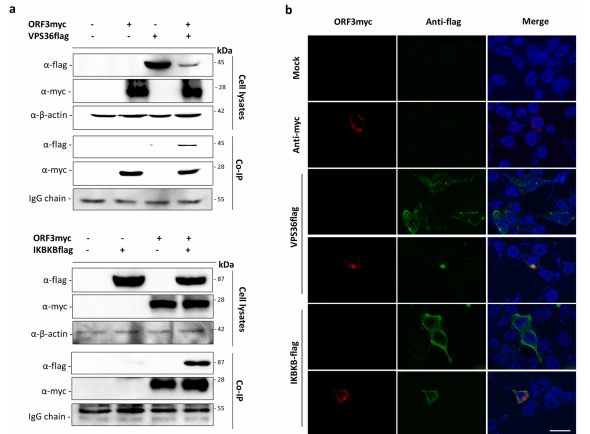
Figure 3. Validation of the interactions of ORF3 with VPS36 and IKBKB by co-immunoprecipitation and indirect immunofluorescence assay (IFA). ( a ) The plasmid expressing VPS36 or IKBKB with flag-tag at the C-terminus (pCAGGS_VPS36 or IKBKBflag) was co-transfected with pCAGGS_ORF3myc in HEK293T cells. At 24 hpt, cell lysates were subjected to immunoprecipitation using anti-myc bead. The immunoprecipitated proteins were probed with rabbit anti-flag and anti-myc antibodies. ( b ) The cells were incubated with mouse anti-myc and rabbit anti-flag as primary antibodies. Goat anti-rabbit IgG Alexa Fluor 488 and goat anti-mouse IgG Alexa Fluor 647 were used as secondary antibodies. Protein localization was analyzed by confocal microscopy. The scale bar is 10 µ